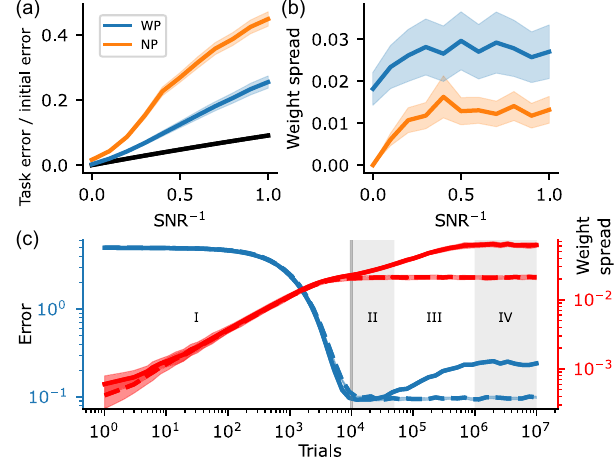
FIG. 5. Influence of input noise on the task error and on the spread of irrelevant weights. (a) Task error (fraction of the initial error) of WP (blue) and NP (orange) at 10 000 trials (curves, means; shading, standard deviations) as a function of inverse signal-to-noise ratio (SNR − 1 ). The noise in the relevant inputs renders the optimal error (black) nonzero. The plot covers SNRs ranging from infinity down to 1. (b) Spread (standard deviation) of irrelevant weights (mean and standard deviation) at 10 000 trials. (c) Evolution of error (blue, mean and SEM) and spread of irrelevant weights (red, mean and SEM) in WP proceeds for weak input noise (SNR − 1 ¼ 0 . 1 ) in four phases (solid curve, phases indicated by numerals). Appropriate weight decay stops the dynamics in phase II and induces long-term results as in the noise-free case [dashed curve; cf. also Fig. 2(b)(ii)]. (a) and (b) use the learning rates that minimize error after 10000 trials [gray vertical line in (c)] for a given noise level (Supplemental Material, Fig. S6 [28]). This implies that WP ’ s error in (a) is the 10 , N ¼ T ¼ 100 , one in phase II. Parameters: M ¼ N eff ¼ α